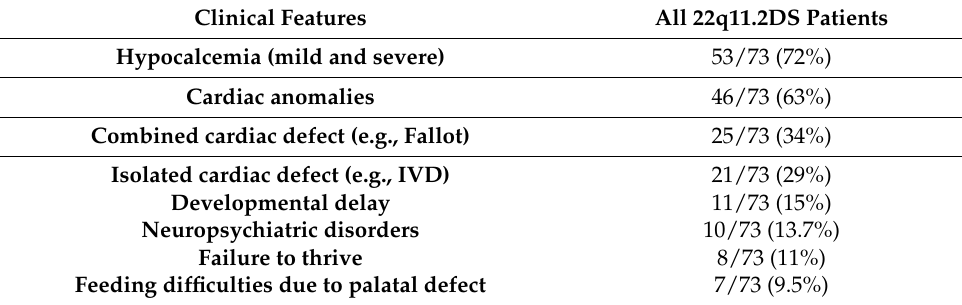
Table 1. Major nonimmunologic clinical features in patients with 22q11.2DS.